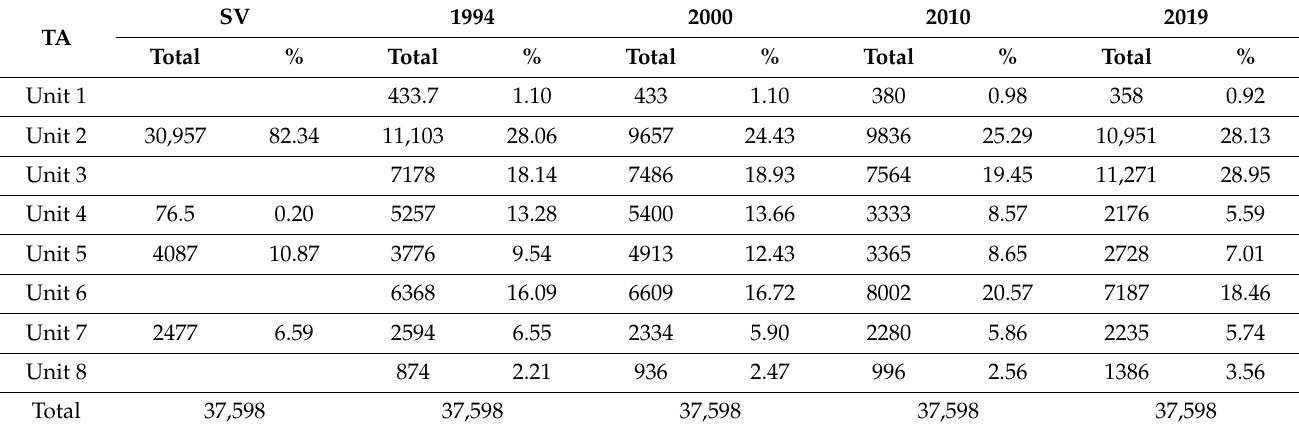
Table 5. Land cover indices in the Jerte Valley, in the years 1994, 2000, 2010, 2019 and in the vegetation series. SV 1994 TA